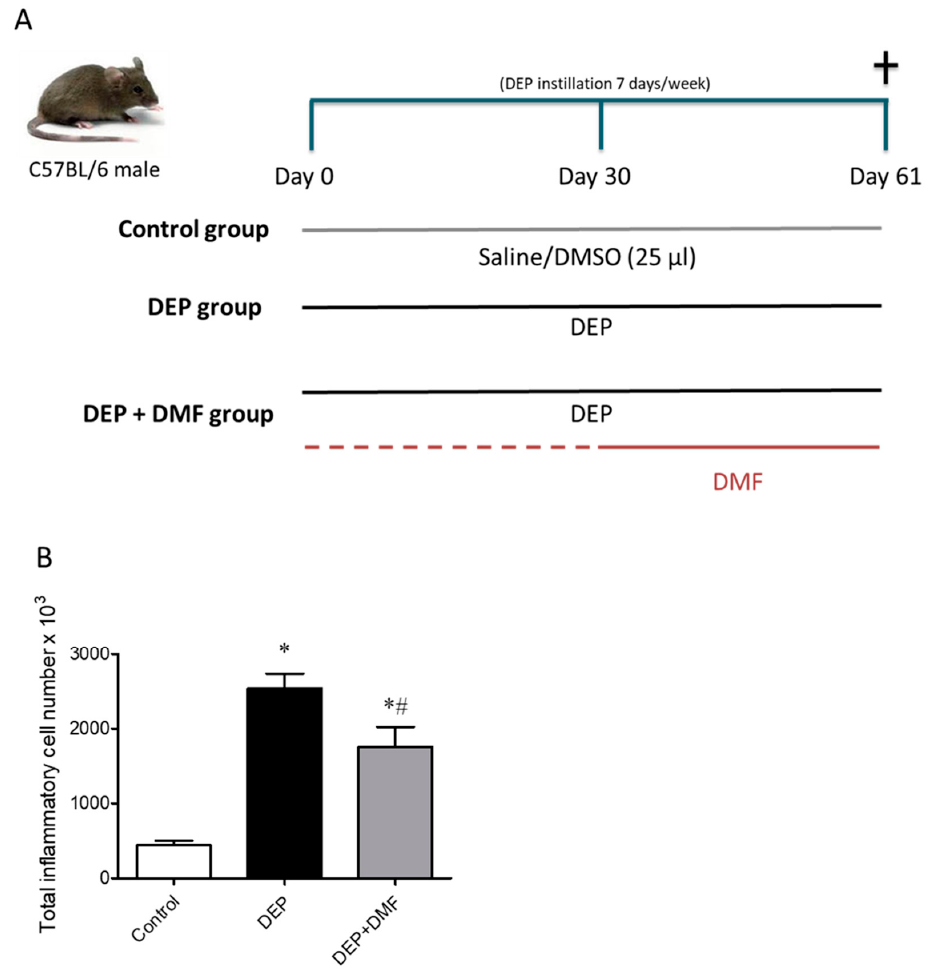
Figure 1. Experimental model and total inflammatory cell number in bronchoalveolar lavage (BAL). ( A ) Schematic representation of the experimental model used in our studies. Mice were either exposed to vehicle (saline / DMSO) or diesel exhaust particles (DEPs) for 60 consecutive days, with or without dimethyl fumarate (DMF) treatment for the last 30 days. ( B ) Total cell number in the bronchoalveolar lavage (BAL) of control and DEP-exposed mice, with or without DMF treatment. Data ( n = 8) are expressed as the mean ± SEM. * p < 0.05 vs. control group, # p < 0.05 vs. DEP group.